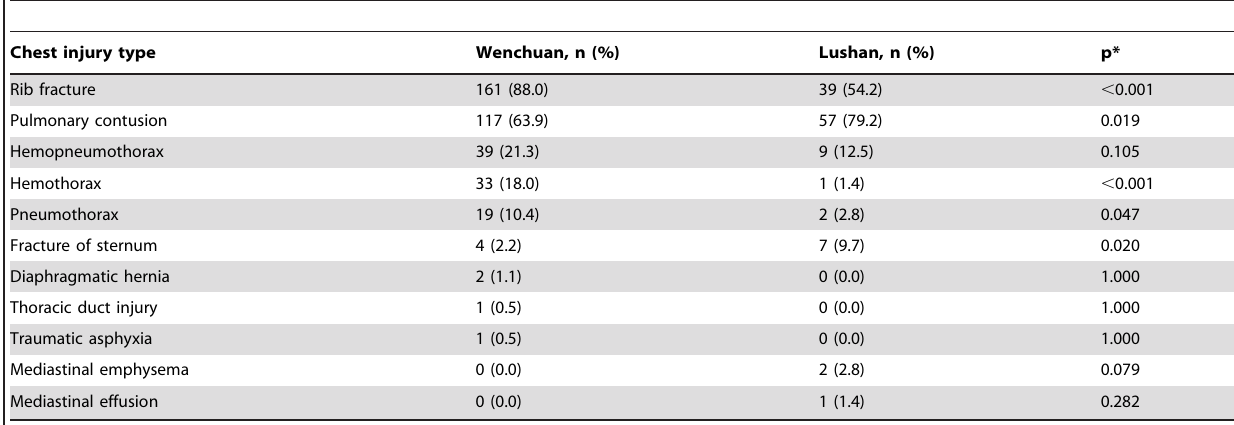
Table 2. Comparison of the prevalence of types of chest injury among patients admitted to our hospital in the Wenchuan and Lushan